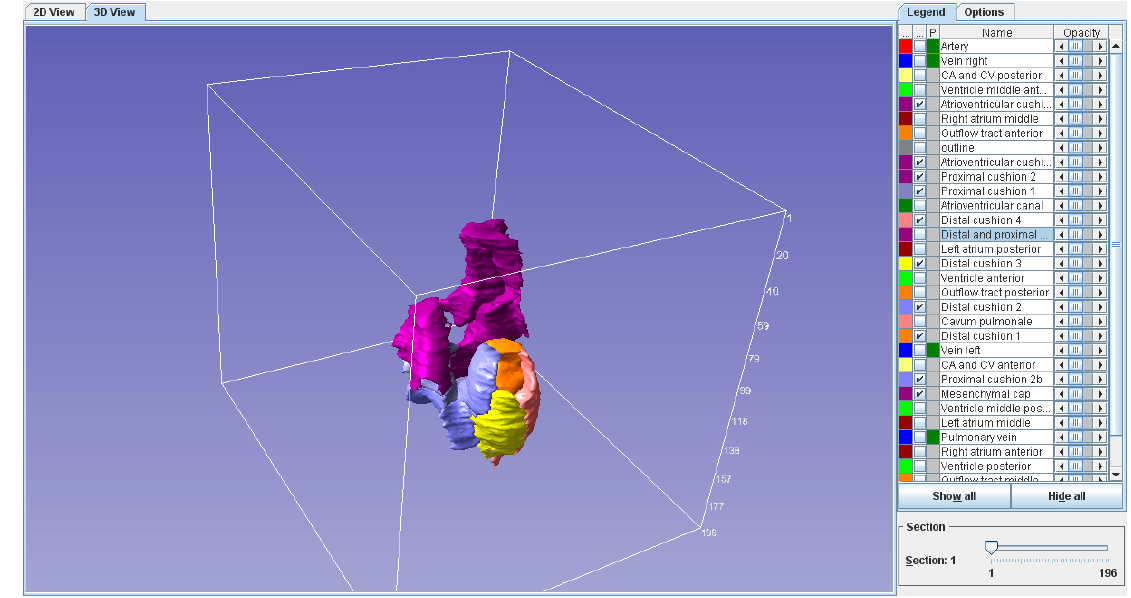
Figure 4: Screen dump of the TDR-3D viewer, in which a set of structures is visualised for the turtle species Emys orbicularis , corresponding to the query described in the